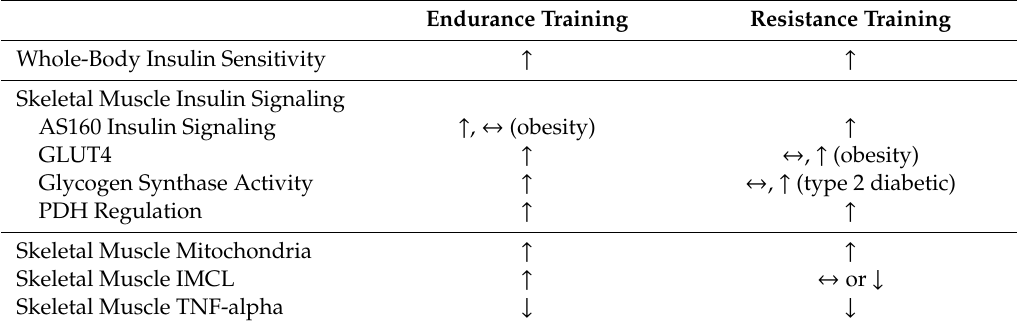
Table 1. Summary of Endurance and Resistance Training E ff ects on Skeletal Muscle Metabolism in Older